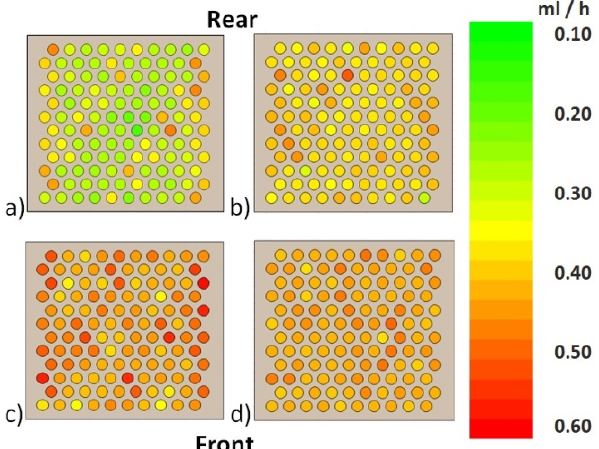
Figure 6. Mapping of sublimation rates in the rack at ( a ) 0.066 mbar, ( b ) 0.133 mbar, ( c ) 0.200 mbar, and ( d ) 0.267 mbar.